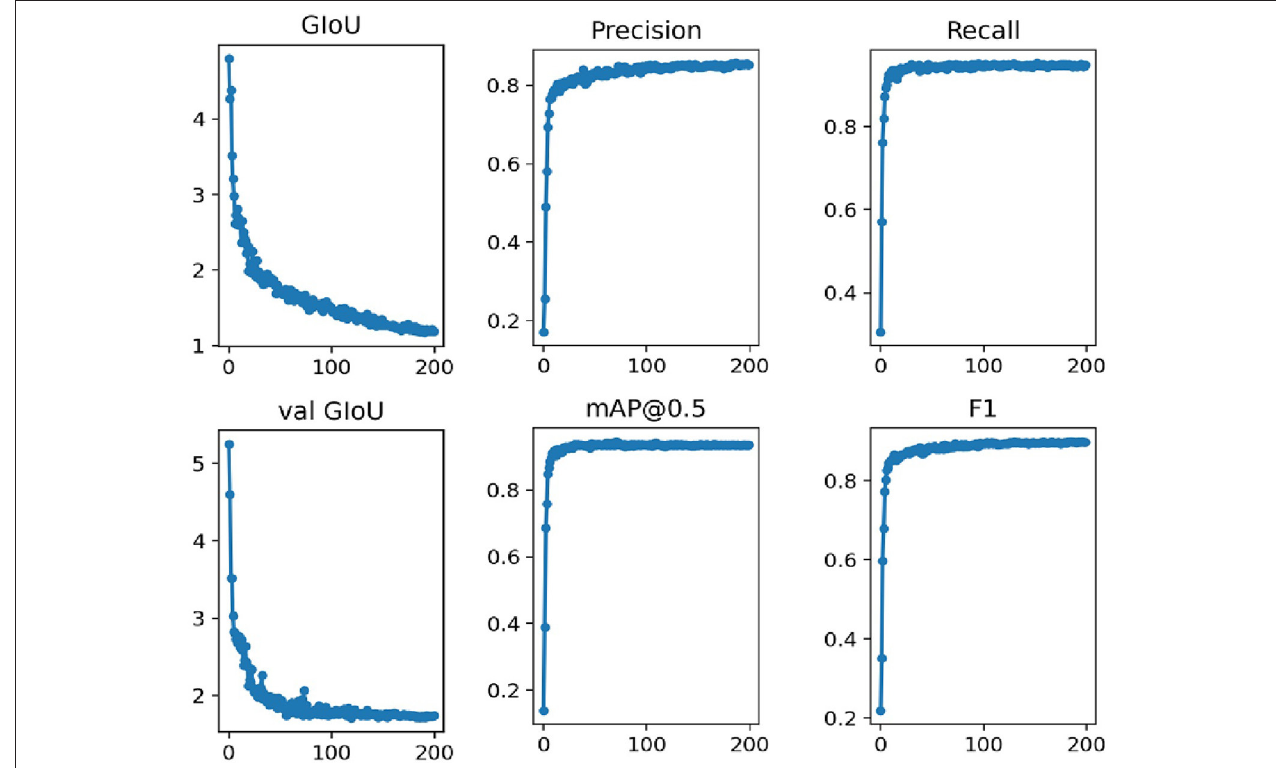
FIGURE 6 | The training performance of YOLOv3-SPP network by using the enhanced dataset.